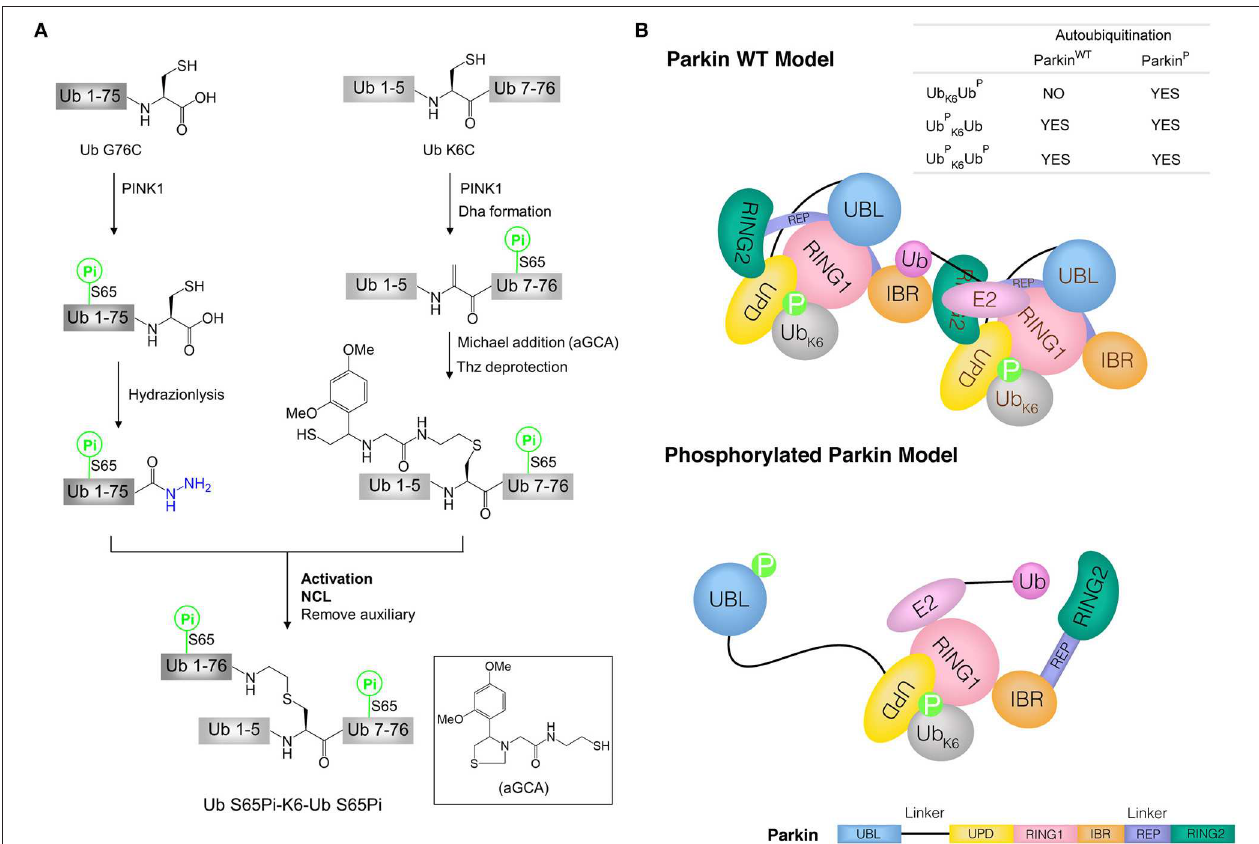
FIGURE 4 | Synthesis of phosphorylated di-ubiquitin and their application in the study of mitophagy. (A) Synthesis of phosphorylated di-ubiquitin chain (K6-linked). (B) Models of Parkin WT and phosphorylated Parkin activated by di-ubiquitin. Parkin consists of an N-terminal UBL domain connected through linkers to four Zn 2 + -binding domains: unique parkin domain (UPD, also known as RING0), RING1 (containing an E2-binding site), in-between RING (IBR), and RING2 (catalytic domain). Parkin C-terminal RING-IBR-RING domains for E3 activity is masked by the Ubl domain. In Parkin wild type (WT) model, two molecules of Parkin cooperate to activate Parkin WT without the release of the UBL domain in the presence of Ub S65Pi-K6-Ub or Ub S65Pi-K6-Ub S65Pi. In phosphorylated Parkin model, phosphorylated UBL is released and catalytic RING2 domain achieves the activation of phosphorylated Parkin by Ub-K6-Ub